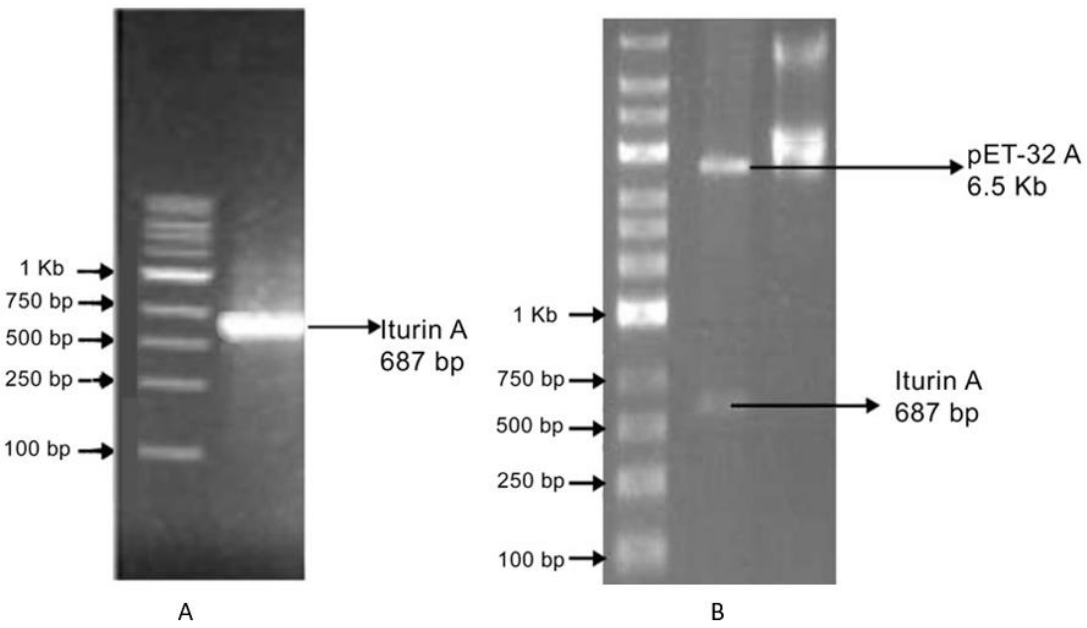
Figure 2. Cloning of the lpa-14 gene from Bacillus aryabhattai : ( A ) amplification of the iturin A gene by PCR and ( B ) recombinant plasmid showing a band size of 687 bp (iturin A gene) and a band size of 6.5 Kb (pET-32A vector).